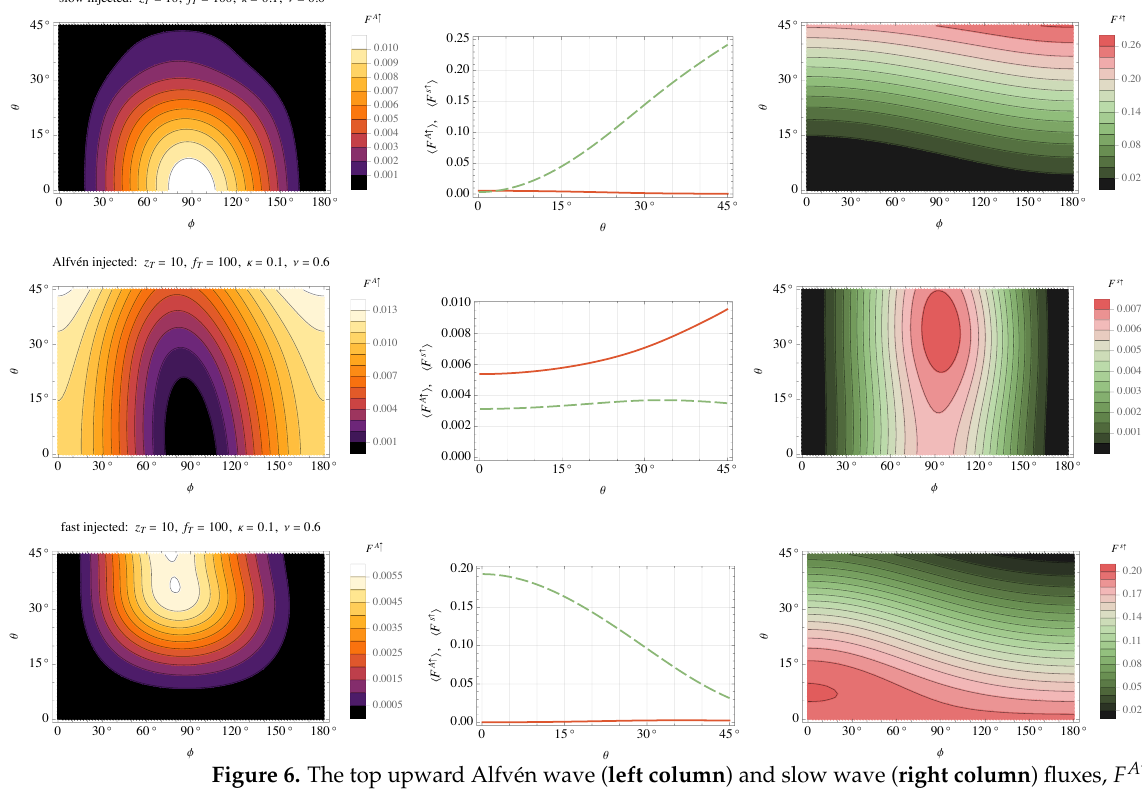
Figure 6. The top upward Alfvén wave ( left column ) and slow wave ( right column ) fluxes, F A ↑ and F s ↑ , as functions of wave orientation φ and magnetic field inclination θ for the case κ = 0.1, ν = 0.6, z T = 10, f T = 100. The centre column plots these fluxes for each θ averaged over all φ , (cid:104) F A ↑ (cid:105) (full curve) and (cid:104) F s ↑ (cid:105)